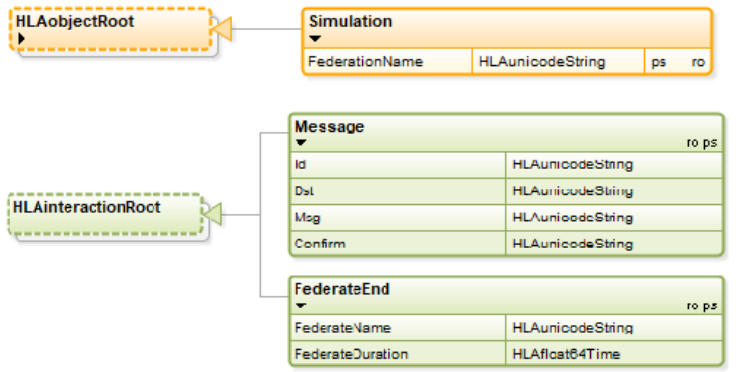
Figure 8. HLA objects and interactions for Papyrus orchestration.